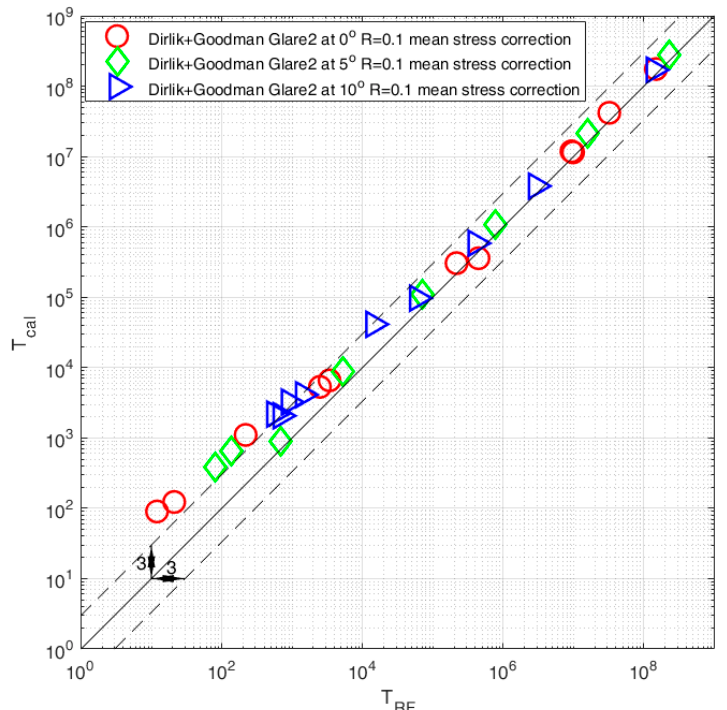
Figure 9. Comparison of fatigue life calculated with the use of the rainflow cycle counting method and the spectral method with the use of the Dirlik model with mean stress compensation with the Goodman model for three fiber orientations θ = 0°, θ = 5°, and θ = 10°.